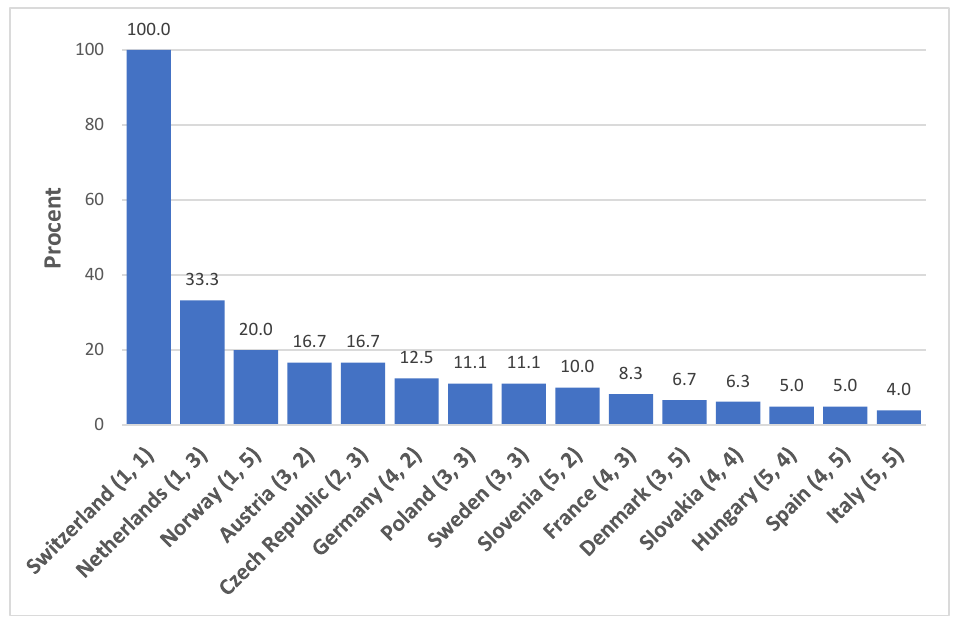
Figure 2. Evaluation of 15 European countries on the basis of the legal status of animals and the criminal aspects of zoophilia (next to the countries, the two rankings are shown in parentheses).